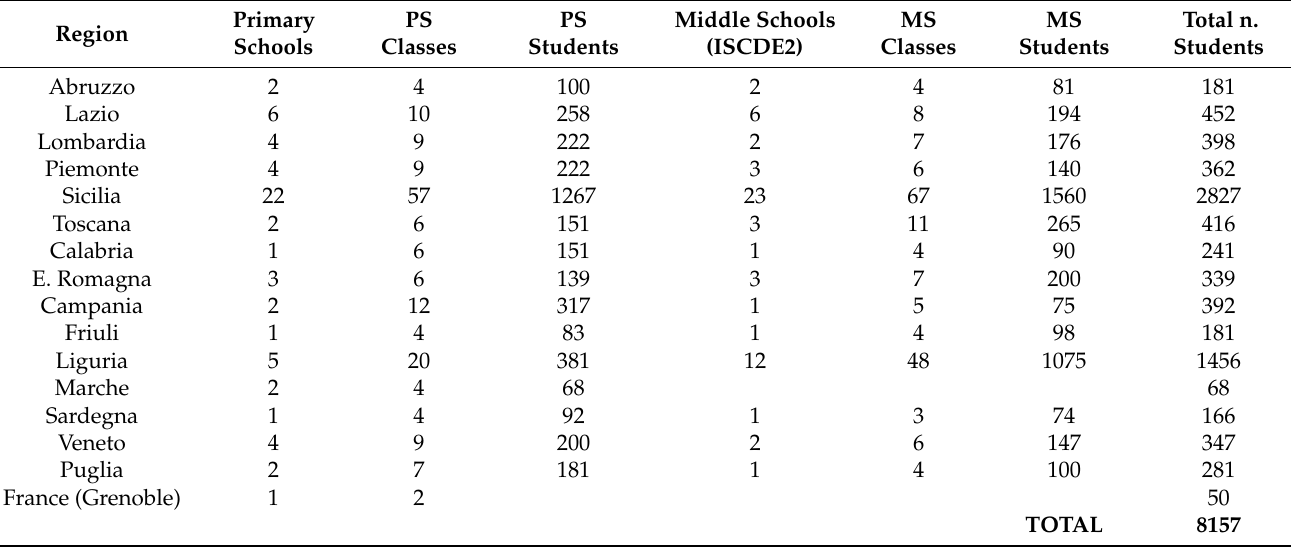
Table 1. Schools involved in all the educational online Salvina’s gaming